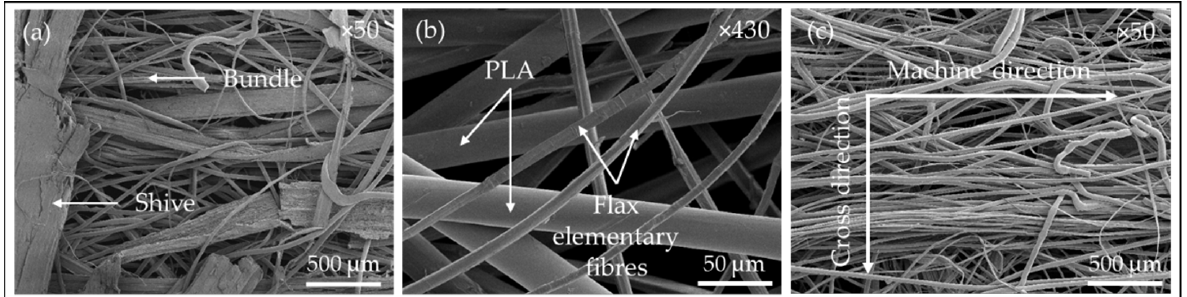
Figure 8. SEM observations for ( a ) Flax tows; ( b , c ) Flax-PLA preform.